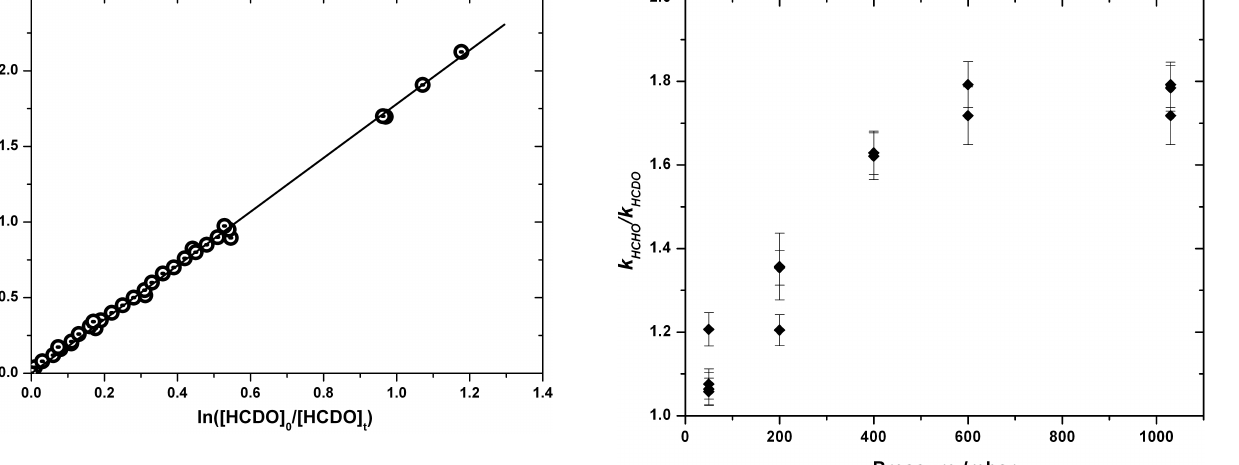
Fig. 2. Relative rate plots of HCHO versus HCDO from three inde- pendent experiments at 293K and total pressure of 1030mbar, error bars within symbols.